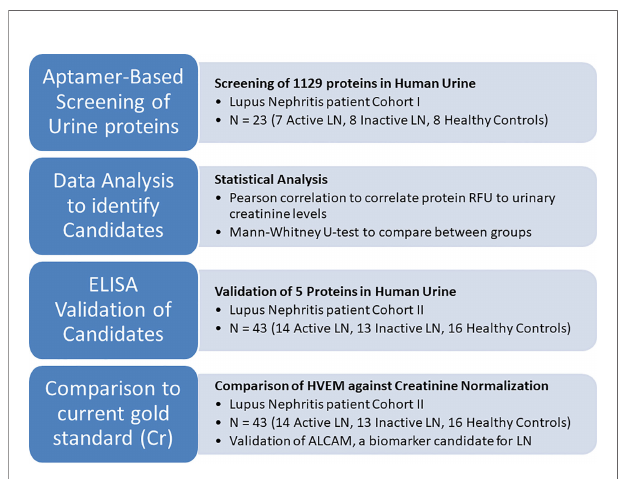
FIGURE 1 | An overview of the current study to identify protein alternatives to creatinine for urine biomarker normalization. First, the urine of 23 human subjects was comprehensively interrogated for 1129 proteins using an aptamer-based proteomic screen. Proteins that correlated well with creatinine and did not differ among patient groups and healthy controls were identi fi ed using Pearson correlation and the Mann-Whitney test, respectively. Of these, 5 proteins were chosen for ELISA validation in an independent cohort of 43 subjects. HVEM, the most promising molecule for urine biomarker normalization, was used to normalize the lupus nephritis biomarker candidate urine